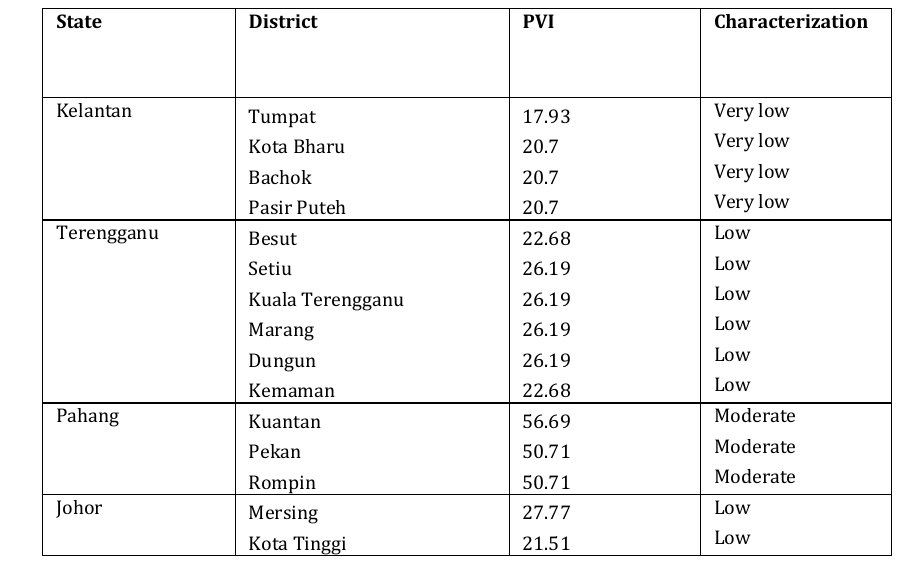
Table 10: Physical vulnerability index along the East Coast of Peninsular Malaysia.